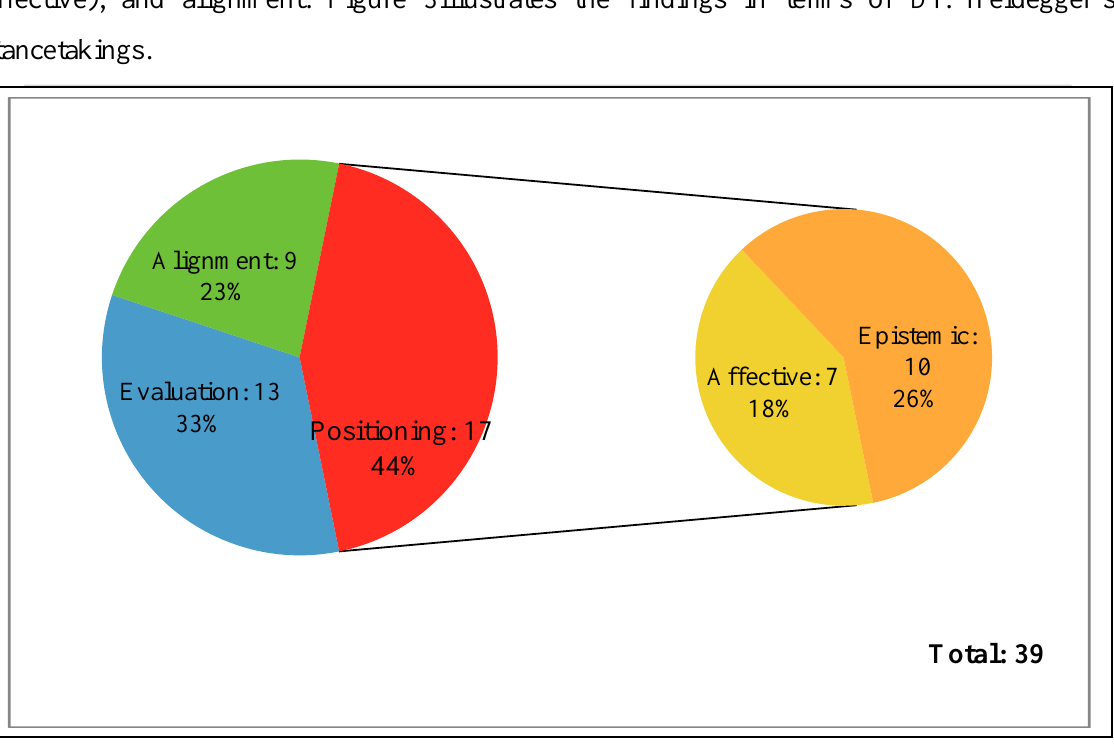
Figure 3: Dr. Heidegger’s Stance